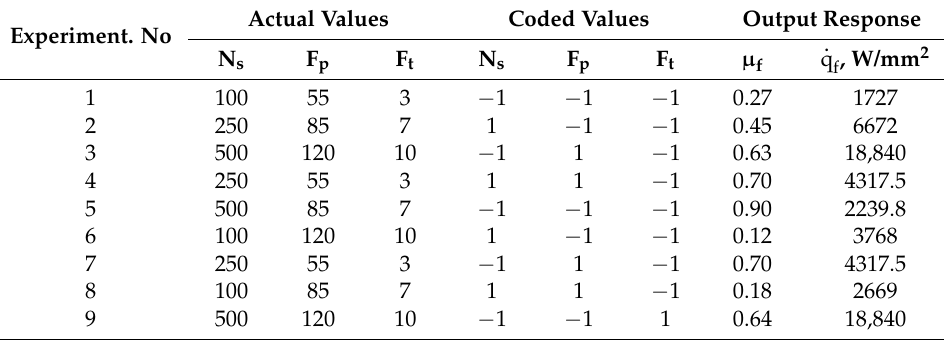
Table 5. Central composite design.